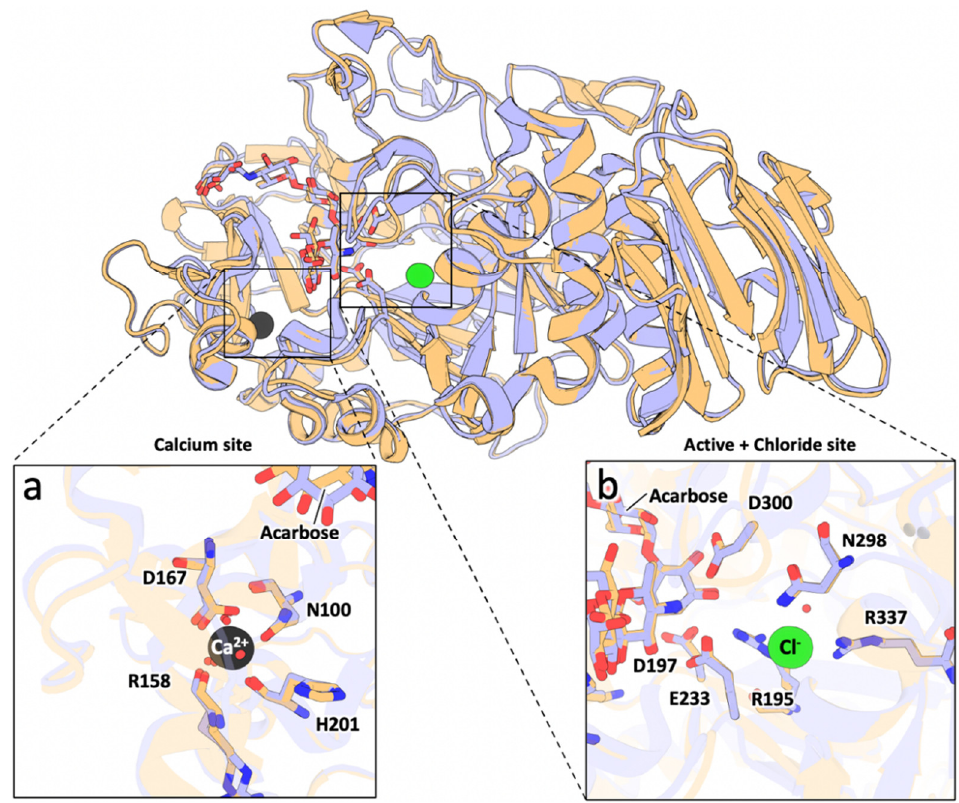
Figure 2. Structural superposition of HSA (lilac) and PPA (orange). Ions are represented as spheres, the catalytic triad and the substrate as sticks and the protein as cartoon (PDB ID: 1mfv and 1ose for HSA ad PPA, respectively). Coordinating water molecules are shown as red spheres. ( a ) Superposition of the calcium-binding site. ( b ) Superposition of the chloride-binding site.